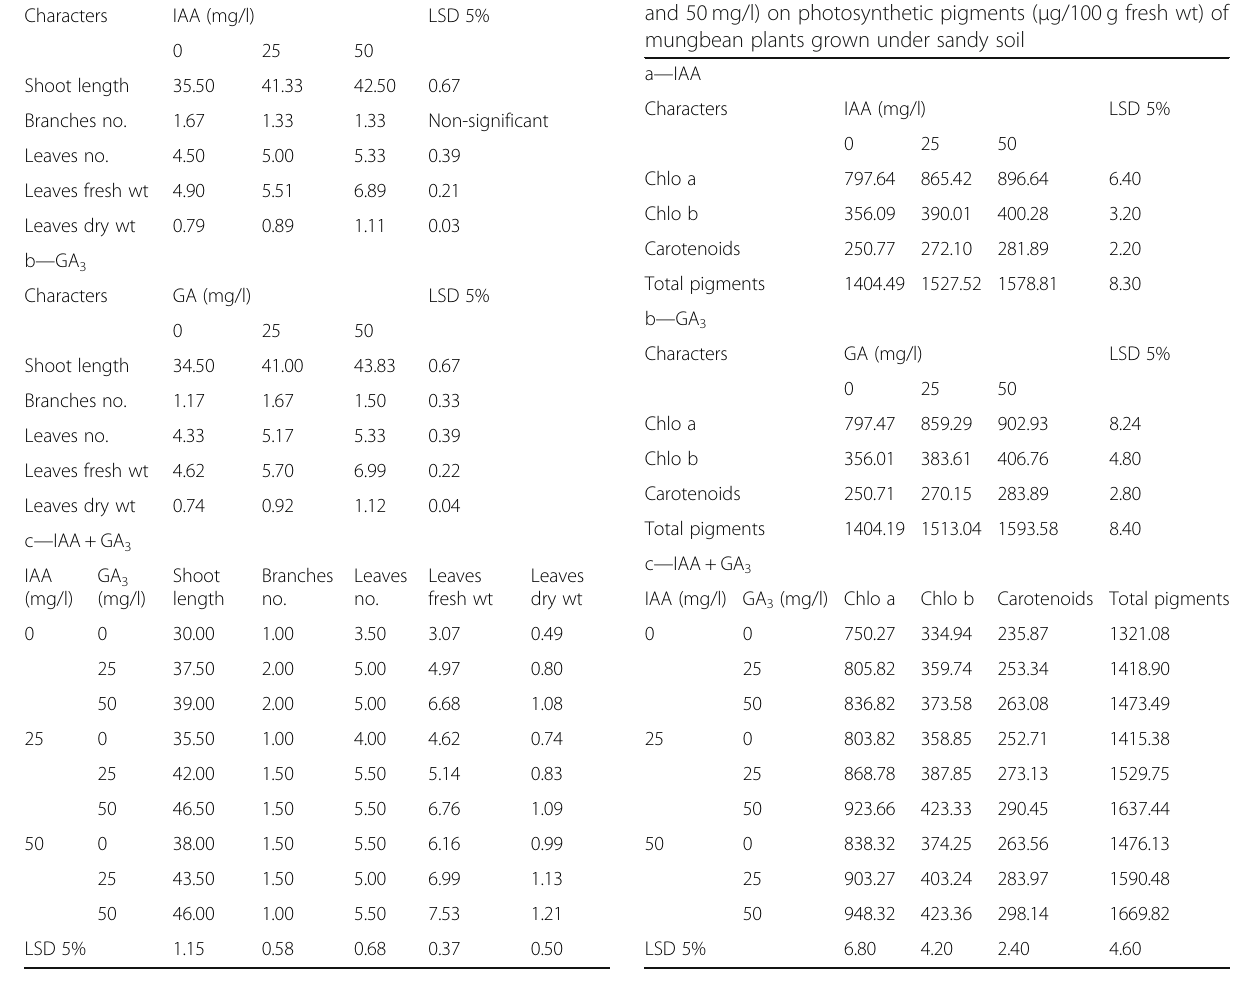
Table 3 Effect of IAA (a) or GA